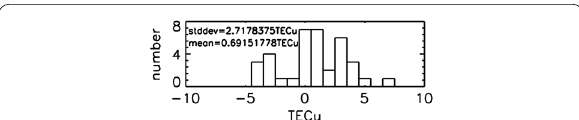
Fig. 9 Number distribution of TEC difference between GPS and GLONASS satellites received by TGRS. The angle between GPS to F7/ C2 and GLONASS to F7/C2 is less than 3° at the same time from day of year 001 to 100 in 2020. A total of 36 pairs of absolute TECs are found and the mean and standard deviations of the difference are around 0.7 TECu and 2.7 TECu,